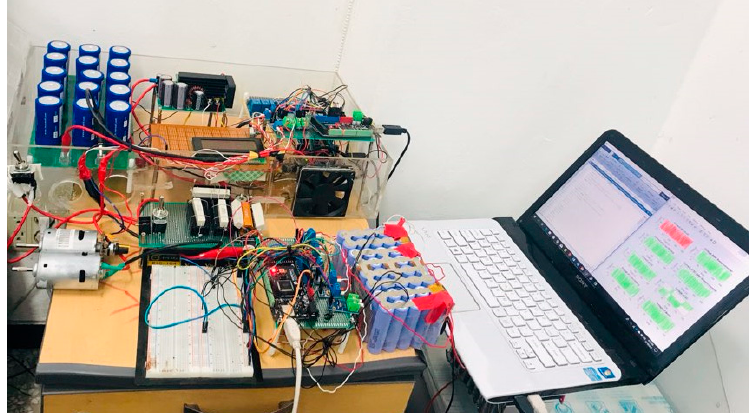
Figure 7. Experimental setup of the prototype.